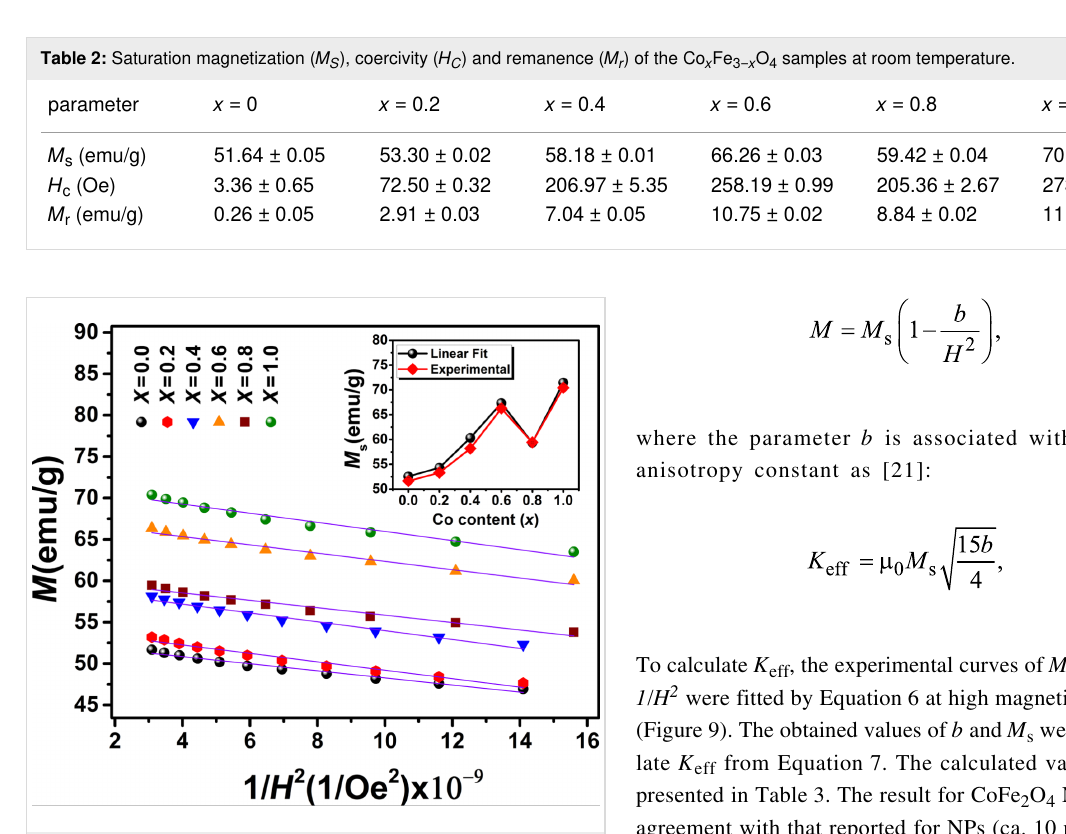
Figure 9: The M –1/ H 2 dependence of the Co x Fe 3 − x O 4 samples at high field strengths. Experimental data are marked by symbols. The solid lines represent a linear fit of the experimental data using Equation 6. The inset shows the saturation magnetization values obtained from the linear fits and the hysteresis loop curves.